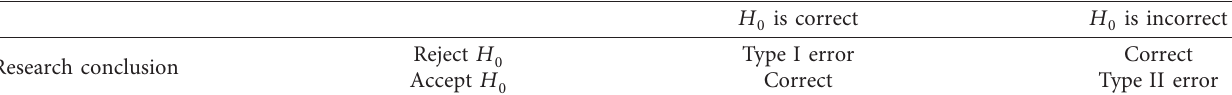
Figure 7: Comparison of the indicators of the four methods on different time scales in the national multistation kernel regression ex- periment: (a) MAE; (b) RMSE; (c) NSC. Table 1: Relationship between two types of statistical